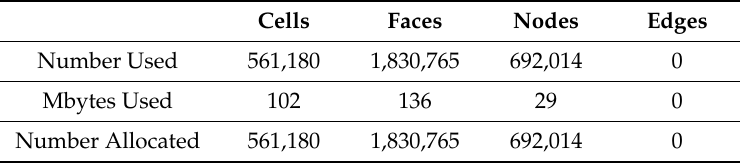
Figure 7. Model axial–radial and circumferential sections grid mesh. Table 2. Statistical results of the number of nodes and